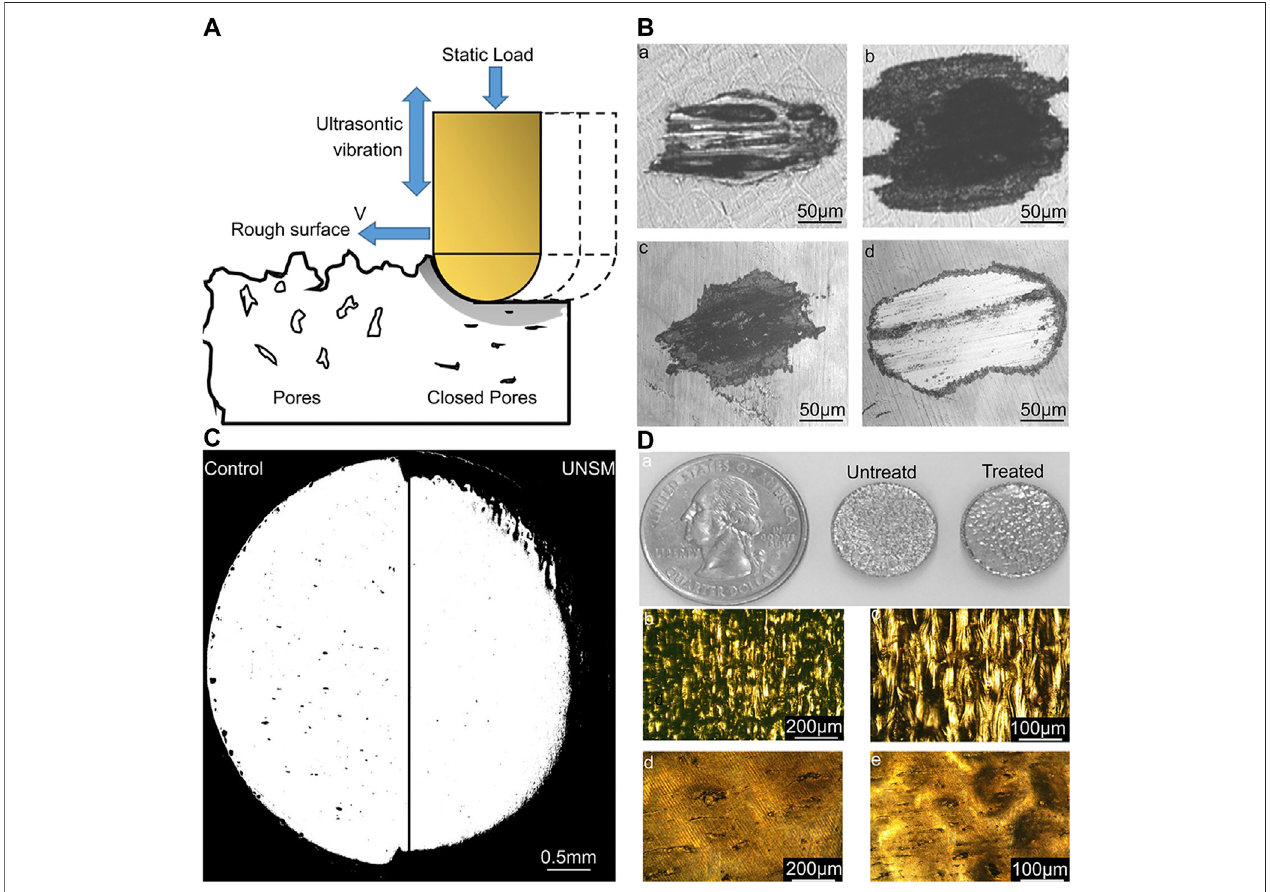
FIGURE8| EffectofUNSMtreatmenton3D-printedNiTialloysurface(Maetal.,2017). (A) SchematicoftheUNSMprocessingshowingitseffectonsurface fi nish, subsurfaceporosity,andsurfacehardening. (B) Wearscarsofuntreated (aandb)samplesandUNSM-treated(candd)samplesat6,000(aandc)and24,000(bandd) cycles. (C) PorositydistributionontheuntreatedsurfaceandUNSM-treatedsurface. (D) a)AppearanceoftheAMNiTisamplesbeforeandafterUNSMtreatment;b)and c) show the optical images of the non-treated sample. d) and e) show the optical images of the UNSM-treated sample. The treated samples have better wear resistance and lower porosity than untreated